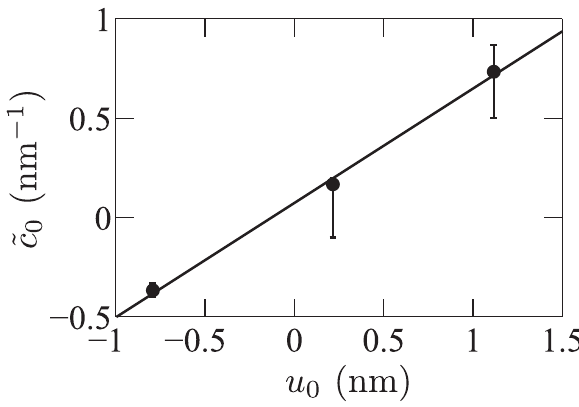
Figure 4. Renormalized spontaneous curvature ~ cc 0 as a function of the hydrophobic mismatch u 0 . Data from Ref. [16], which presents fits of simulation results for inclusions with three different hydrophobic thicknesses. Line: linear fit, with slope (0 : 56 + 0 : 02)nm { 2 . Note that our ~ cc 0 corresponds to twice that in Table 2 of Ref. [16], as we work with total curvatures instead of average curvatures. The error bars on ~ cc 0 are those listed in that table, and u 0 corresponds to 2 t el table.